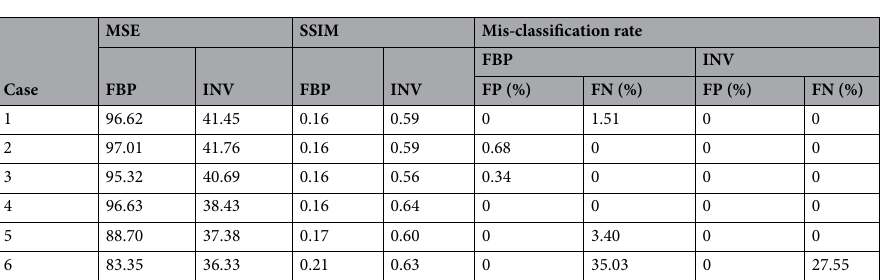
Table 2. Comparison of image quality and mis-classification rates for the six simulated cases reconstructed using traditional FBP and the inverse (INV) approach. FP: false positive (missing pins mis-classified as present) rate; FN: false negative (present pins mis-classified as missing) rate.